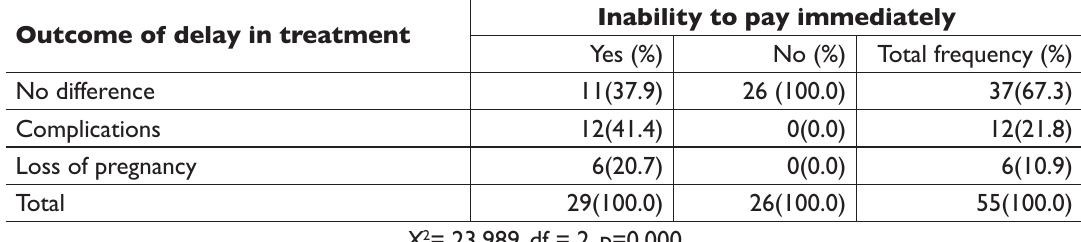
Inability to pay immediately and treatment outcome Outcome of delay in